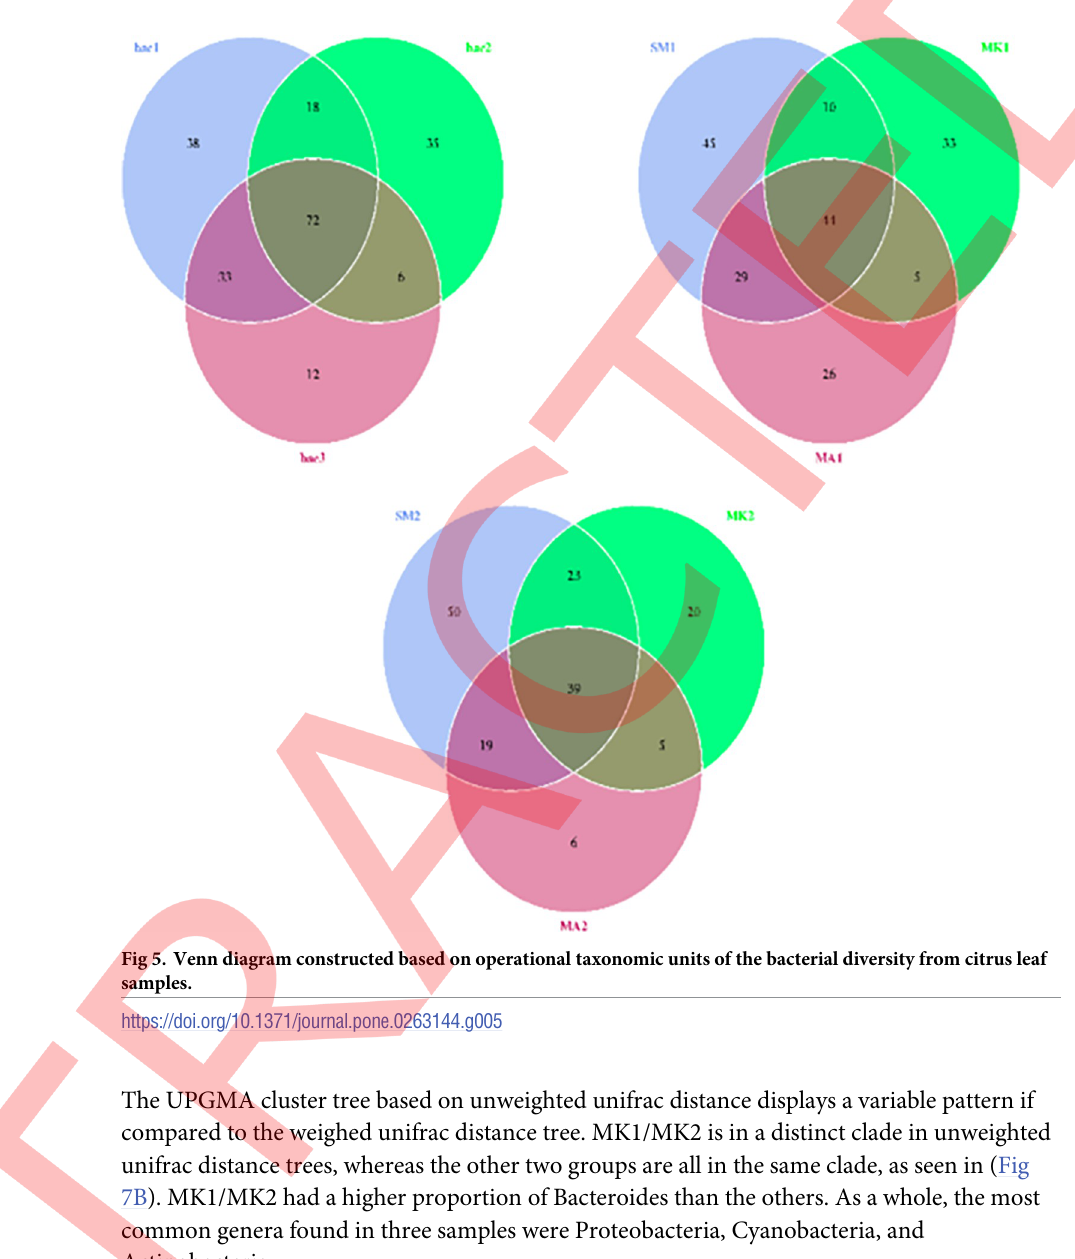
Fig 5. Venn diagram constructed based on operational taxonomic units of the bacterial diversity from citrus leaf samples.